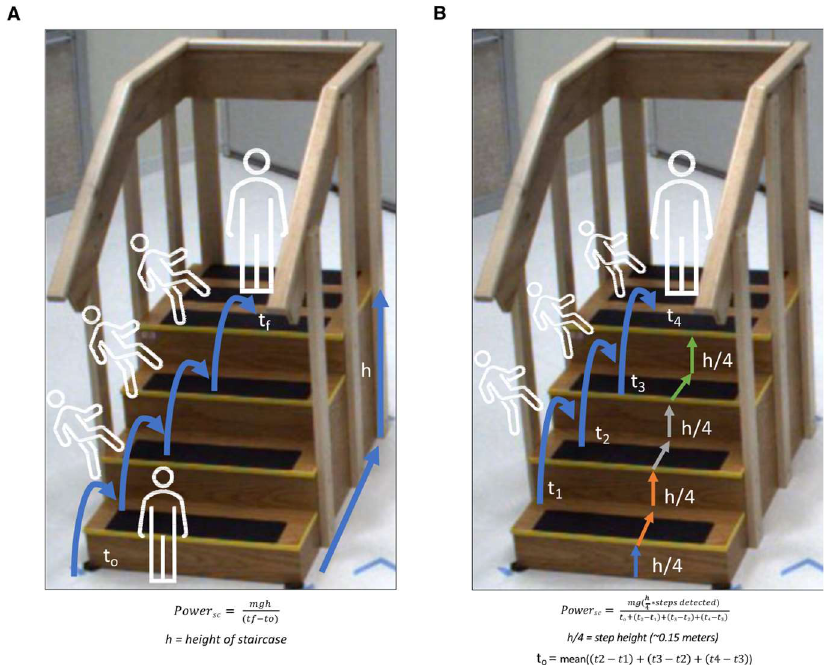
Figure 1. Schematic view of ( A ) Standard (four-step) SCP, where the participant starts with both feet on the ground at time 𝑡 0 , which is the time when the clinician says “go”, and finishes at time t f when both feet touch the top step, and ( B ) StairPy SCP estimation, where the participant starts climbing when the clinician says “go”, and finishes when both feet reach to last step at 𝑡 4 . In this method, the each step ( t 1 , t 2 , t 3 , t 4 ) are derived from the StairPy, and the time between the clinican says “go” and the 1st step ( t 0 ) is estimated as the average time between steps (mean (( t 2 − t 1 ) + ( t 3 − t 2 ) + ( t 4 − t 3 )). [42].